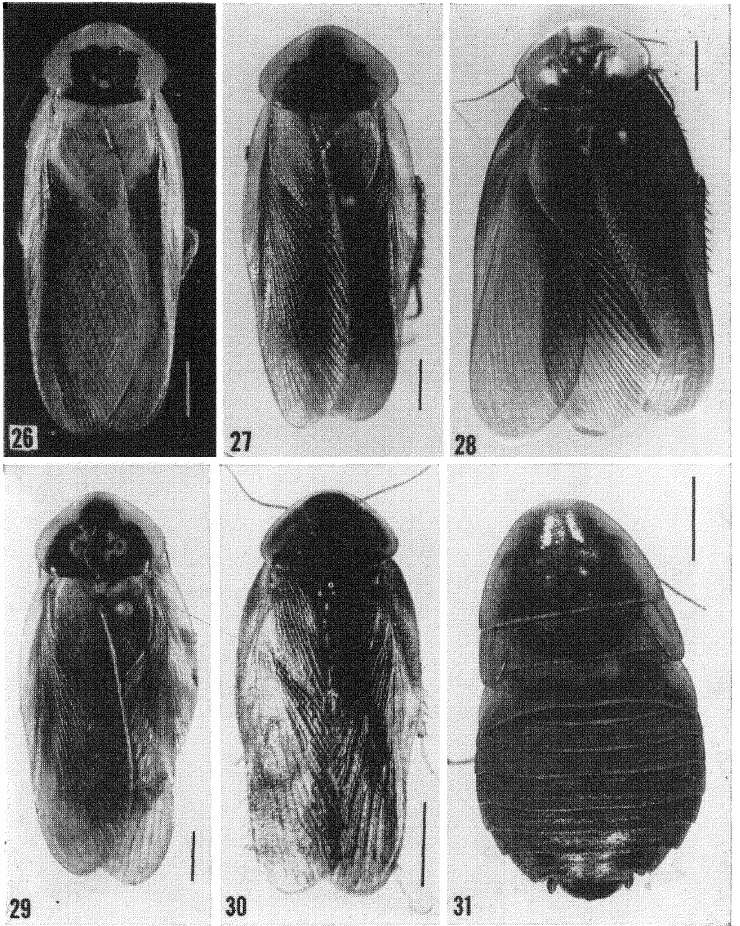
Figs. 26-31. 26. (20 ANSP). Blaptica interior Hebard. Formos.a, Argen- tina. (det. Rehn). 27. (22 ANSP). Blaptica obscura Saussure and Zehnt- ner. So Leopoldo, Rio Grande do Sul, Brazil (det. Rehn.) 28. (64 USNM). Minablatta bipustulata (Thunberg). Vi(.osa, Minas Geraes, Brazil (det. Rehn). 29. (21 ANSP). Blaptica dubia (Serville). Buenos Aires, Argentina (det. Hebard). 30. (N). Hyporhicnoda litomorpha Hebard. Panama. (det. Gurney). 31. (6 ANSP). Styphon bakeri Rehn. Paratype, Curaqao, Dutch West Indies. (scale